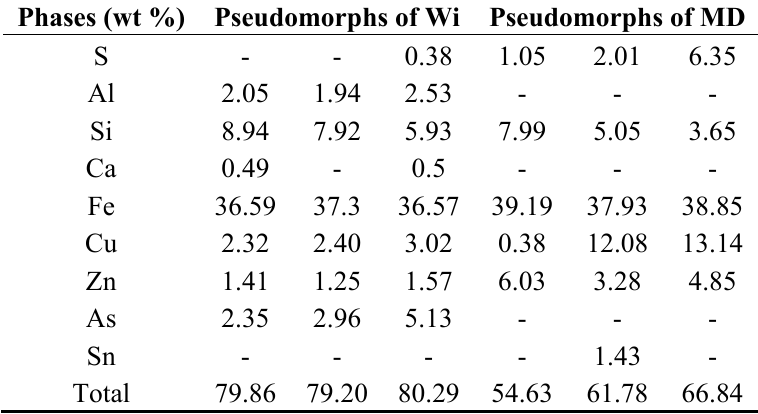
Table 7. Chemical compositions of pseudomorphs of willemite and matte drop obtained by EDS. Wi: willemite; MD: matte drop. “-” indicates non-detected.